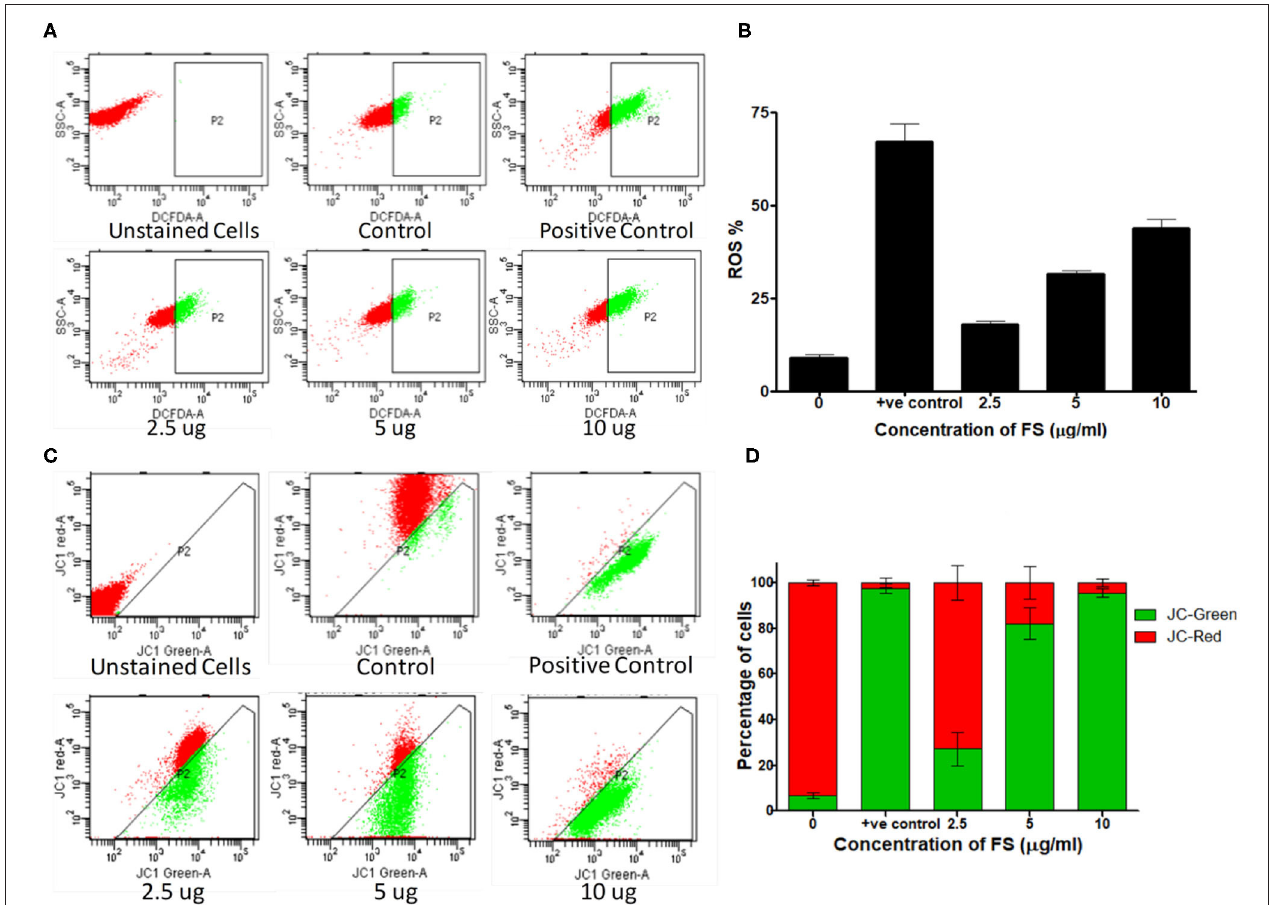
FIGURE 4 | Mechanism of apoptosis induced by fungal taxol (FS). (A) Effect of FS on reactive oxygen species (ROS) production. Cells treated with the indicated concentration of FS were stained with 2 ′ ,7 ′ -dichlorodihydrofluorescein diacetate dye, and the intracellular ROS was monitored by flow cytometry. (B) The bar diagram represents the percentage of cells that produced ROS. Data are presented as mean ± SEM, n = 3. (C) Effect of FS on the loss of mitochondrial membrane potential. Cells were treated with the indicated concentration of FS for 24h and subsequently analyzed for changes in mitochondrial membrane potential by JC-1 staining using flow cytometry. (D) The bar diagram represents the percentage of JC-red and JC-green cells. Data are presented as mean ± SEM, n =